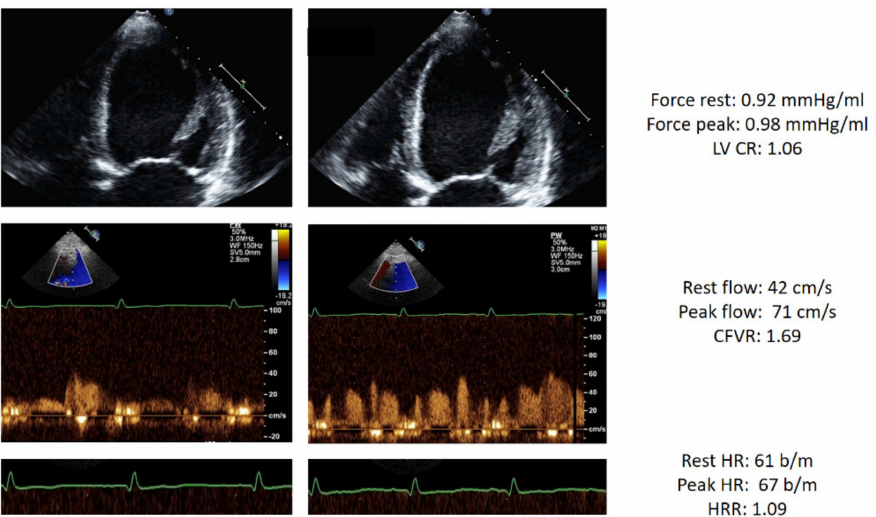
Figure 2. Stress echo with abnormal score 3 in a patient with HF. Left column: rest. Right column, stress. From top to bottom: dilated end-systolic volume at rest which does not decrease during stress (force rest = 0.92 mm Hg/mL; stress = 0.96 mm Hg/mL) with abnormal LVCR (1.06); blunted increase of pulsed-wave Doppler peak diastolic flow (rest = 42 cm/s; stress = 71 cm/s; CFVR = 1.69); abnormal heart rate reserve: heart rate rest = 61; peak = 67 bpm; heart rate reserve (67/61) = 1.09. Abbreviations: CFVR, coronary flow velocity reserve; EKG, electrocardiogram; HRR, heart rate reserve; LAD, left anterior descending coronary artery; LV, left ventricle; LVCR, left ventricular contractile reserve.